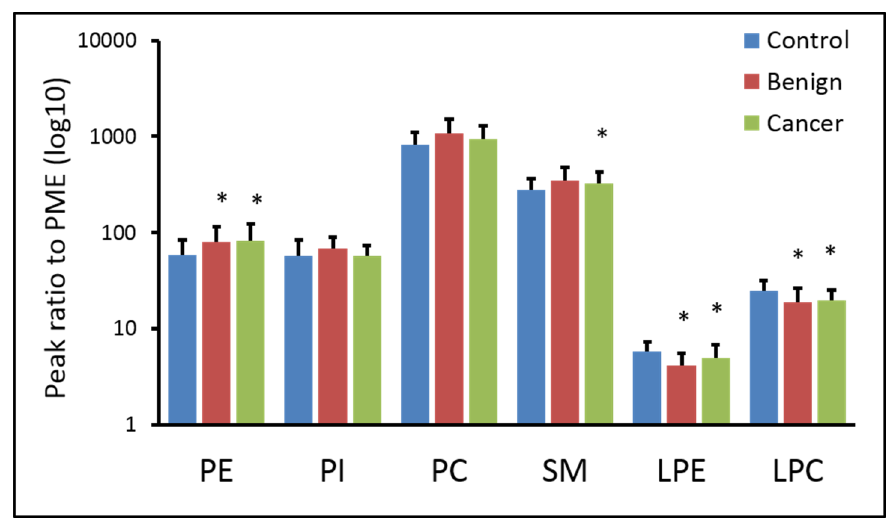
Figure 1. Content of individual classes of phospholipids and lysophospholipids. There is no major difference in the contents of plasma phospholipids (PME, internal standard; PE, phosphatidylethanolamine; PI, phosphatidylinositol; PC, phosphatidylcholine; SM, sphingomyelin; LPE, lysophosphatidylethanolamine; LPC, lysophosphatidylcholine; *, p < 0.05 against control).